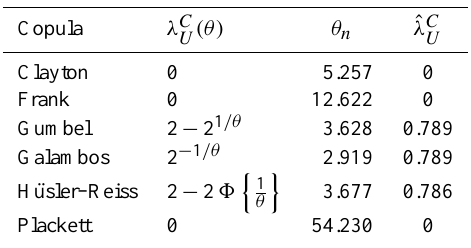
Table 5. Upper tail dependence coefficient of the considered